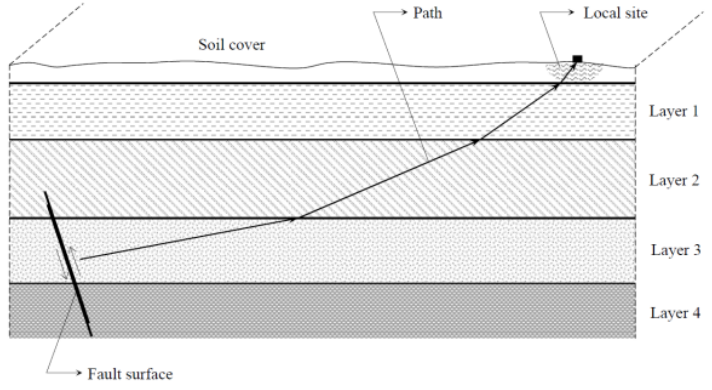
Figure 1. Physical mechanisms of seismic wave